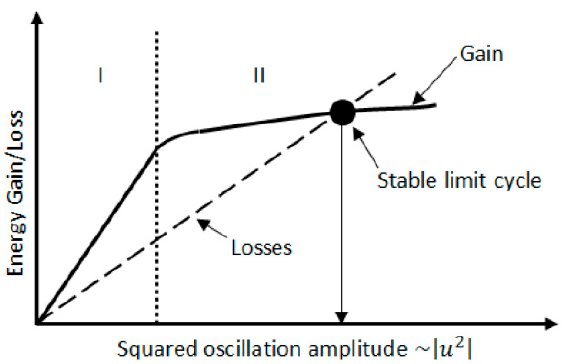
Figure 1. Interaction between energy losses and energy gain via unsteady heat addition [30]. Region I: linear gain, region II: non-linear gain.